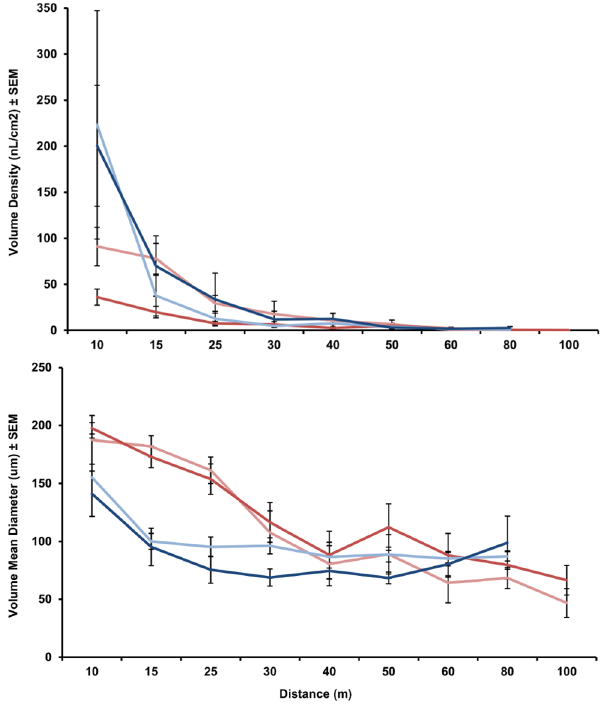
Figure 2. Volume density and droplet sizes of VectoBac WDG applied with a CSM2 and LV-8 at 400 and 800 g/ha in an open- field. Red=CSM2, blue=LV-8, light colors=400 g/ha, dark col- ors=800 g/ha.